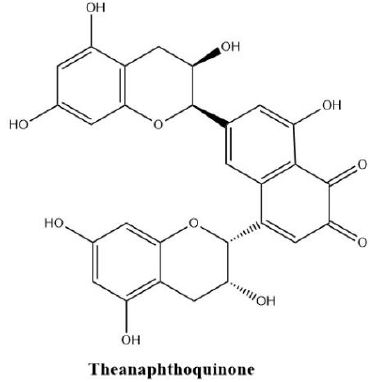
Figure 6. The structure of theanaphthoquinone.